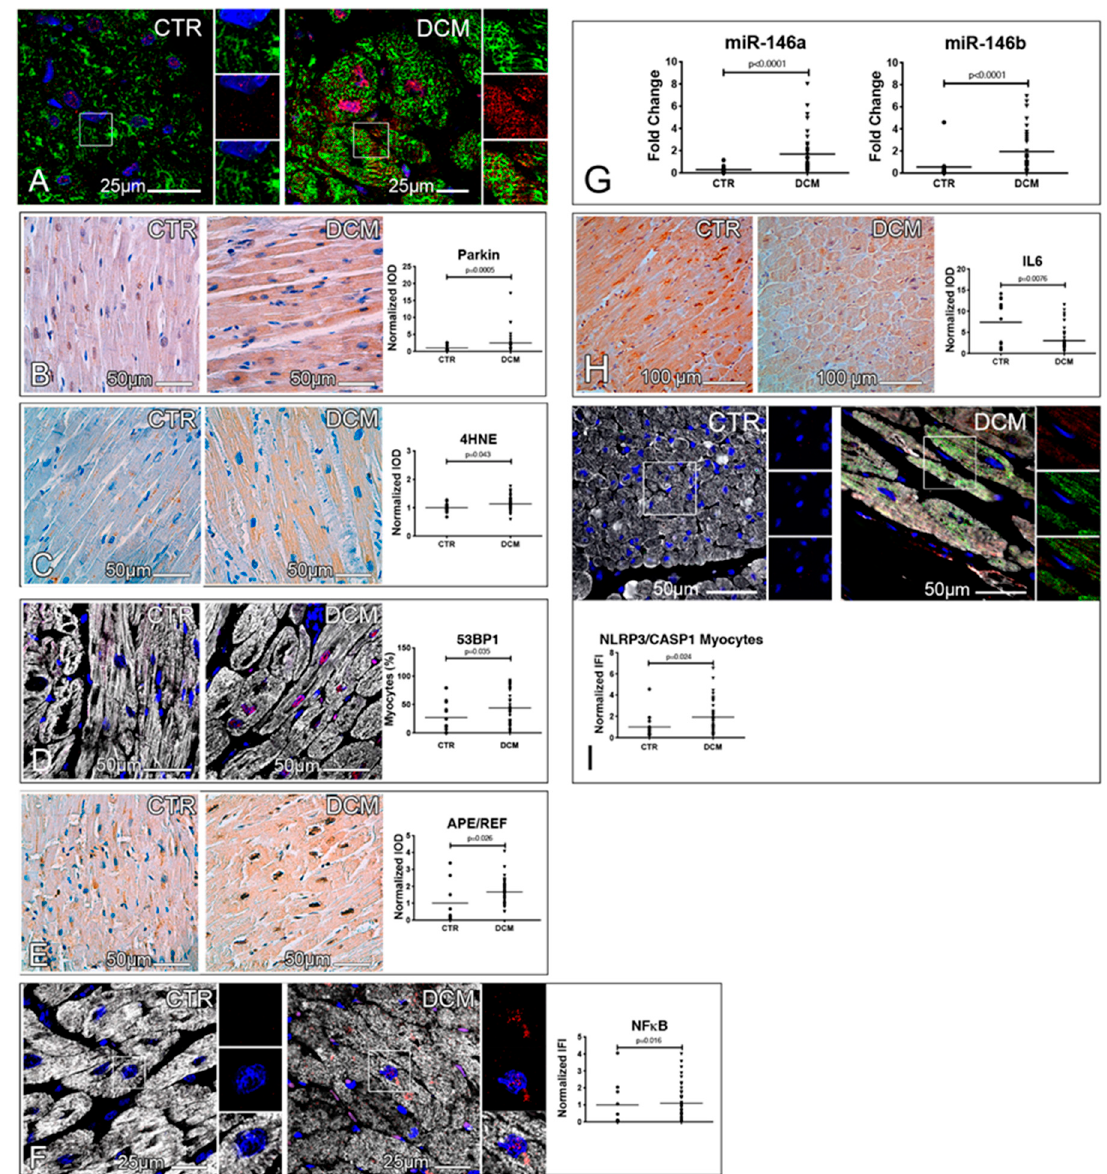
Figure 3. Evidence of the accumulation of dysfunctional mitochondria, lipoperoxidation products, and activated inflammasomes in explanted hearts. ( A , B ) Mitochondrial dysfunction. Confocal images